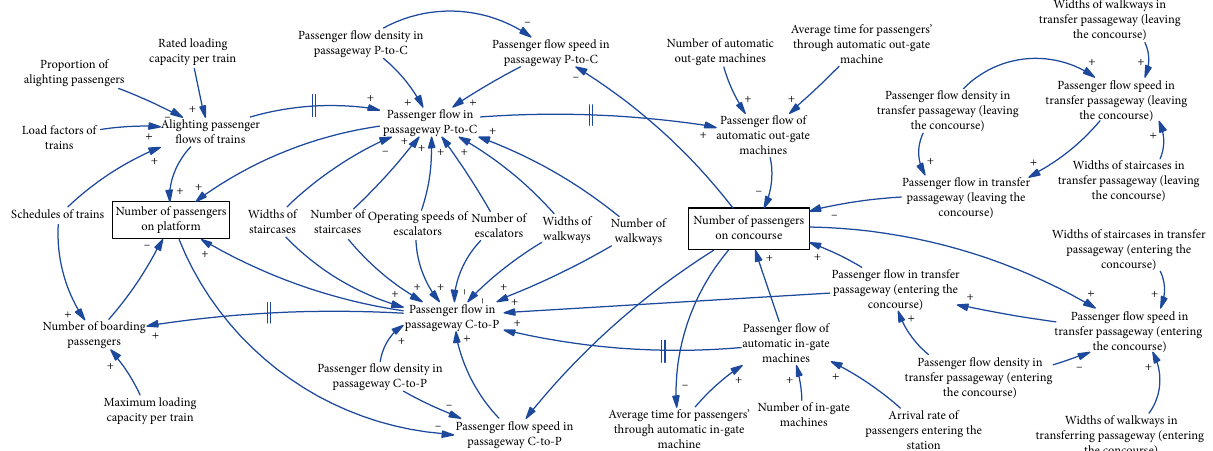
Figure 1: Causal-loop diagram for the transfer station. Facilities in the unpaid zone are excluded from the range of study. P-to-C represents the flow direction from the platform to the concourse and C-to-P vice versa. The walkway is different from the passageway; the former is one kind of facilities, and the latter represents a set of serial facilities including escalators, staircases, and